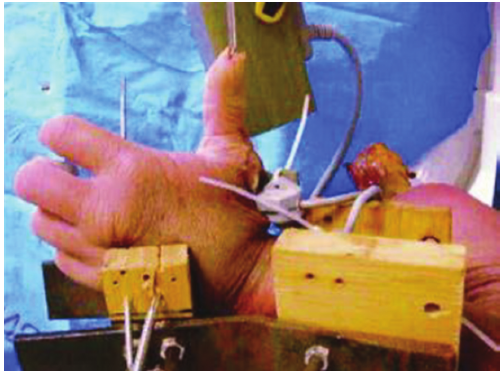
Figure 1: Photograph of a specimen secured in the custom-made jig. The forearm is at 45-degree supination and the wrist at 20- degree dorsiflexion, thumb pointing